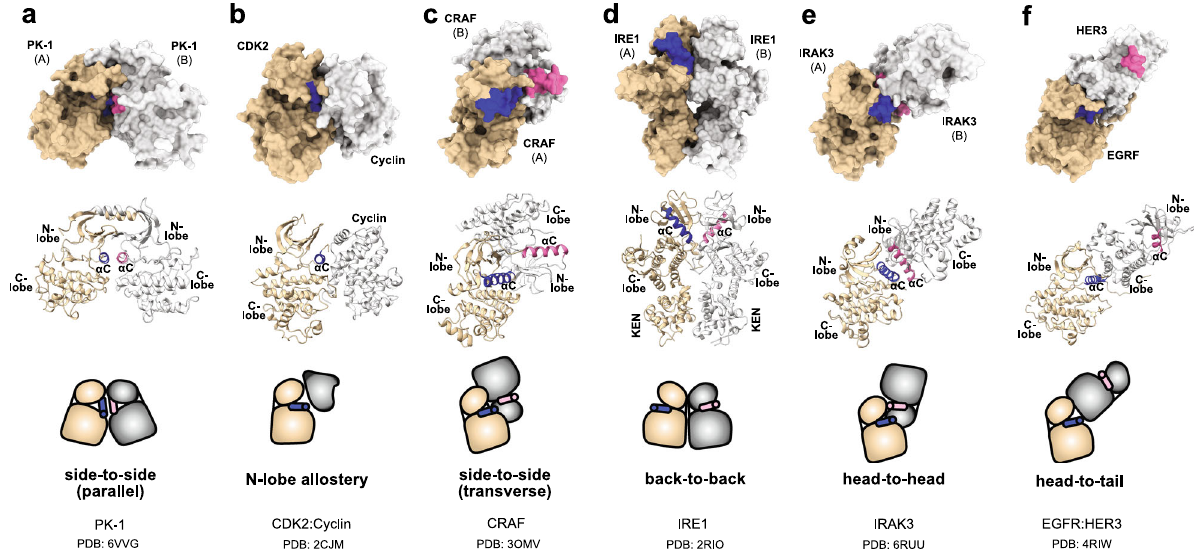
Fig. 5 Comparison of known modes of kinase dimerization and allostery. a Parallel side-to-side homodimer PK-1 (PDB 6VVZ; solved in this study); b allosteric regulation of CDK2 via N-lobe binding to Cyclin (PDB 2CJM) 77 ; c transverse side-to-side homodimer CRAF (PDB 3OMV) 38 ; d back-to-back homodimer IRE1 (PDB 2RIO) 41 ; e head-to-head homodimer IRAK3 (PDB 6RUU) 40 ; f head-to-tail heterodimer EGFR:HER3 (PDB 4RIW) 42 . Each allosteric or dimerization mode is illustrated by molecular surface (top panel), cartoon ribbon (middle panel) and schematic representation (lower panel). Protomer A and B are coloured tan and grey, respectively. The α C-helix ( α C) from protomer A and B are highlighted in dark blue and pink, respectively. The N-lobe (N) and C-lobe (C) are shown, and the KEN domain that contributes to the IRE1 dimer interface is indicated in d